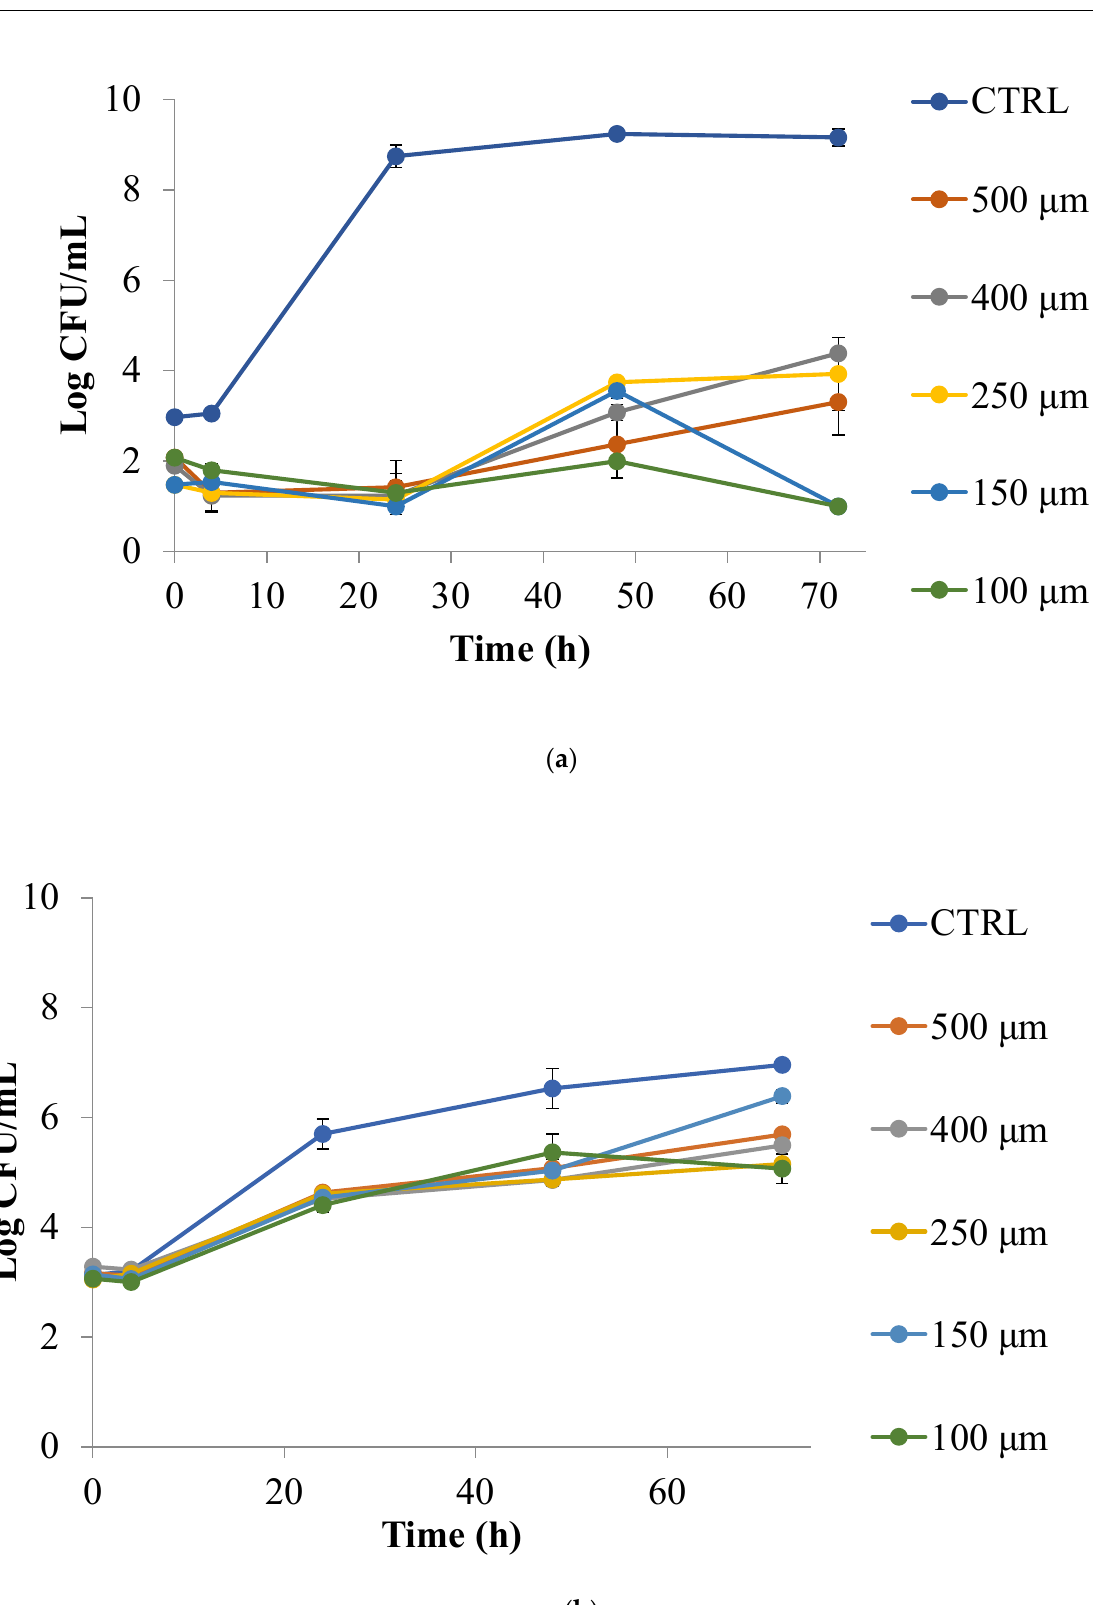
Figure 2. Pseudomonas spp. ( a ) and yeasts ( b ) in PC broth with (5%) and without PPP with granulometry from 500 to 100 µm.